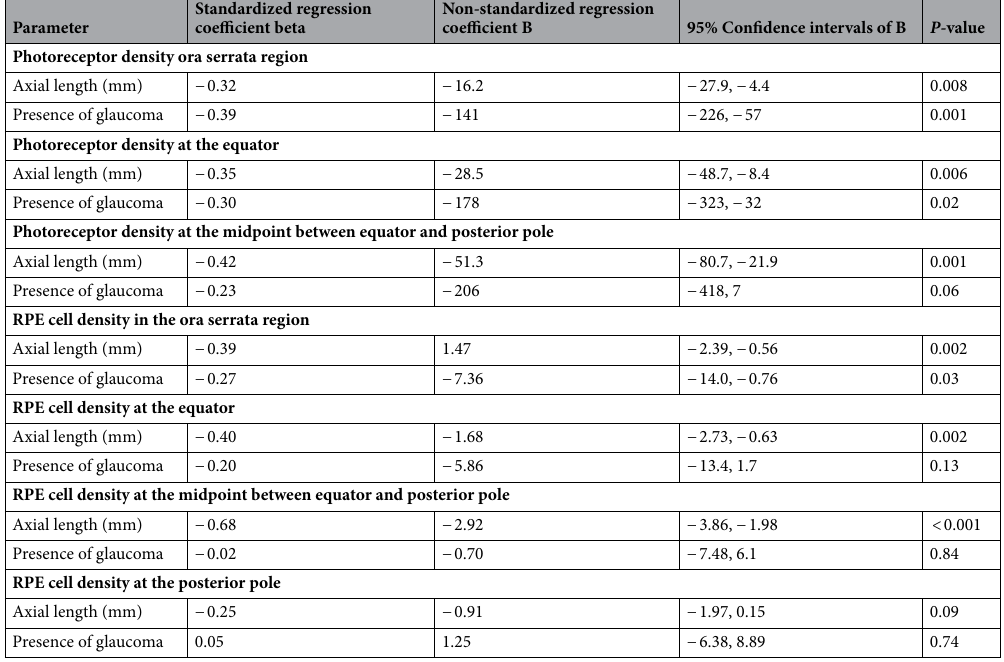
Table 4. Associations of the photoreceptor density and retinal pigment epithelium (RPE) cell density with axial length and the presence of glaucoma (multivariable